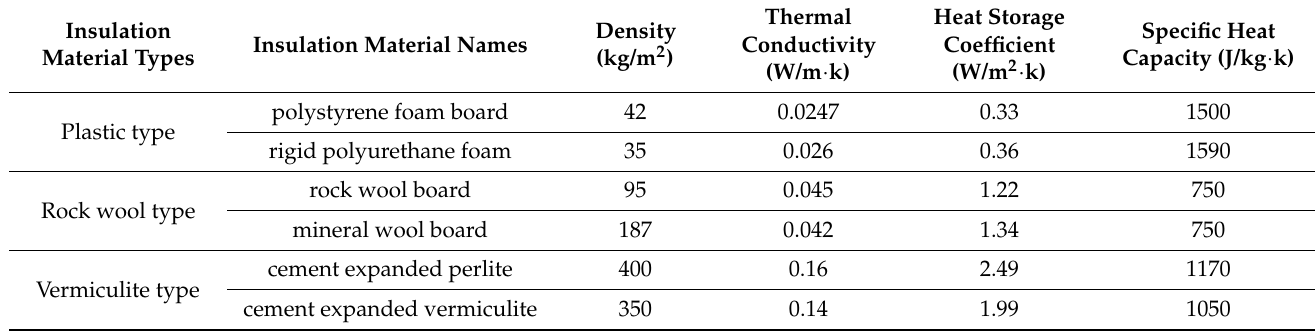
Table 7. Thermal physical properties of different insulation materials